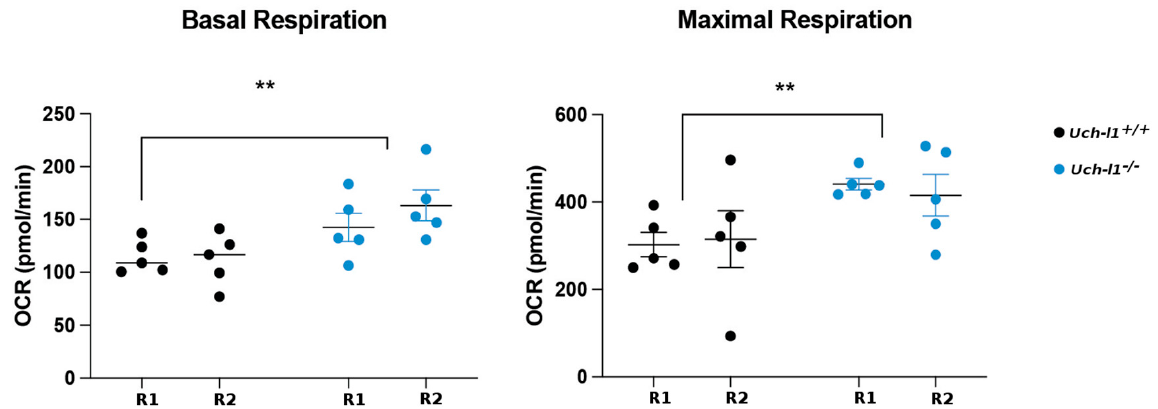
Figure 7. Representative Figure of OCR assessment and quantification of basal, maximal respiration, and respiration used for ATP production per biological replicate ( n = 10 per biological replicate). ** represents significant differences p < 0.01.